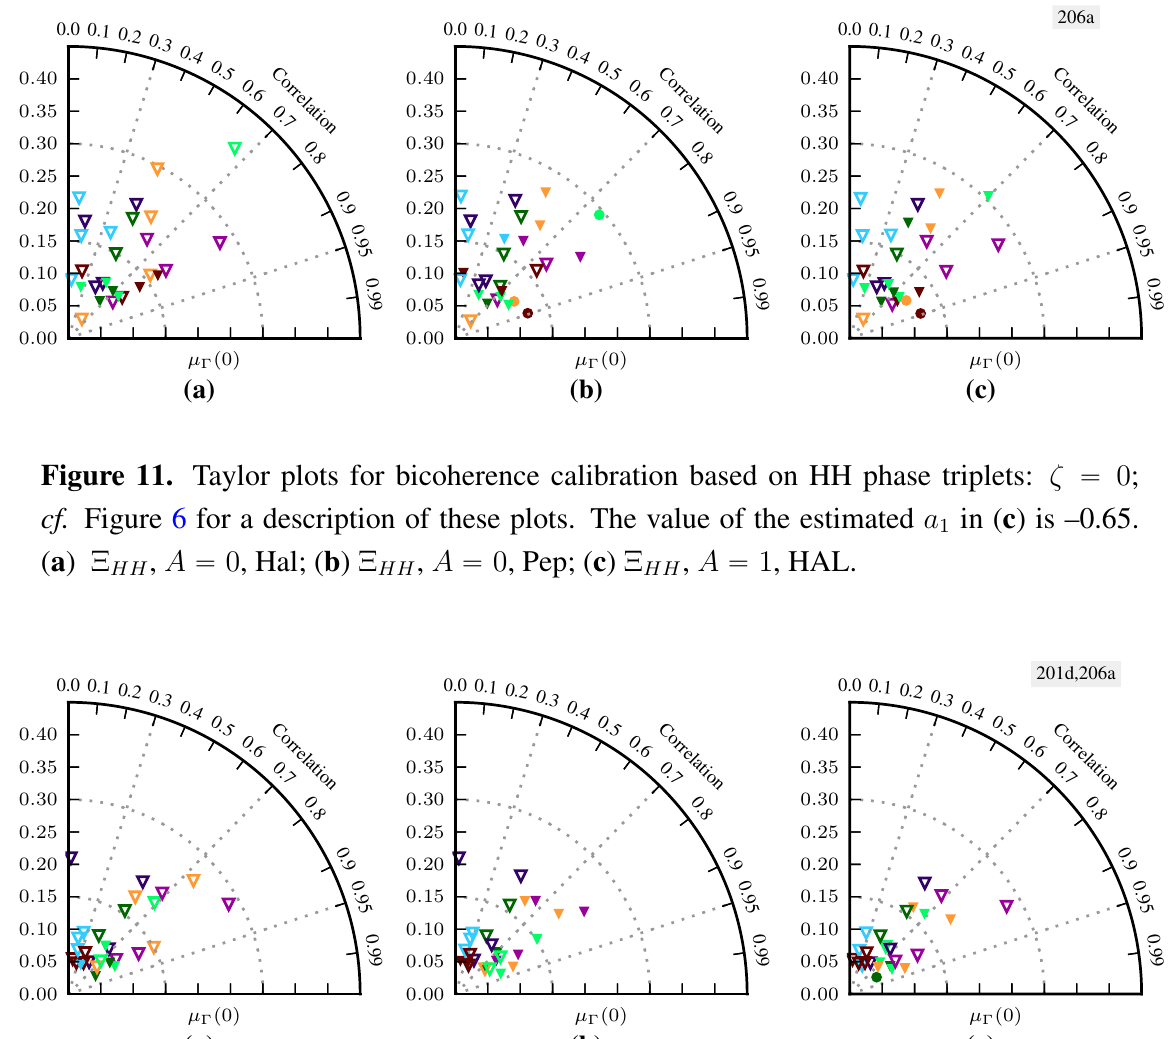
, A “ 0 , Hal; ( b ) Ξ , A “ 0 , Pep; ( c ) Ξ , V V V V V V